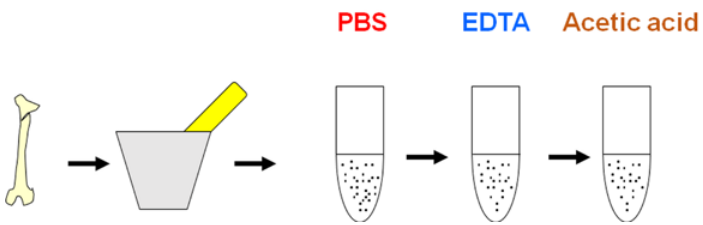
Figure 1. Preparation of fossil